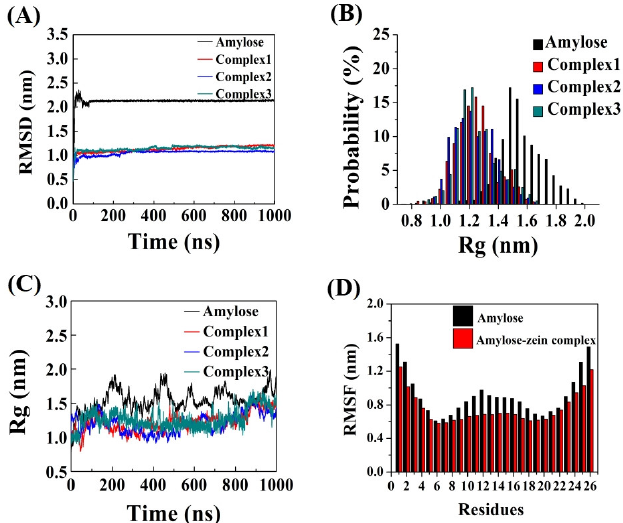
Figure 3. ( A ) Root mean square deviation (RMSD) of amylose molecule (black line) and three amylose–zein complexes with different initial values (red, blue and green lines); ( B ) Distribution of radius of gyration (R g ) of amylose molecule (black bars) and three amylose–zein complexes with different initial values (red, blue and green bars); ( C ) Radius of gyration (R g ) of amylose molecule (black line) and three amylose–zein complexes with different initial values (red, blue and green lines); ( D ) Root mean square fluctuation (RMSF) values of each glucose residue of amylose molecule in single-strand system (black bars) and the average RMSF values of each glucose residue of amylose molecule in three different amylose–zein complexes with different initial values (red bars).